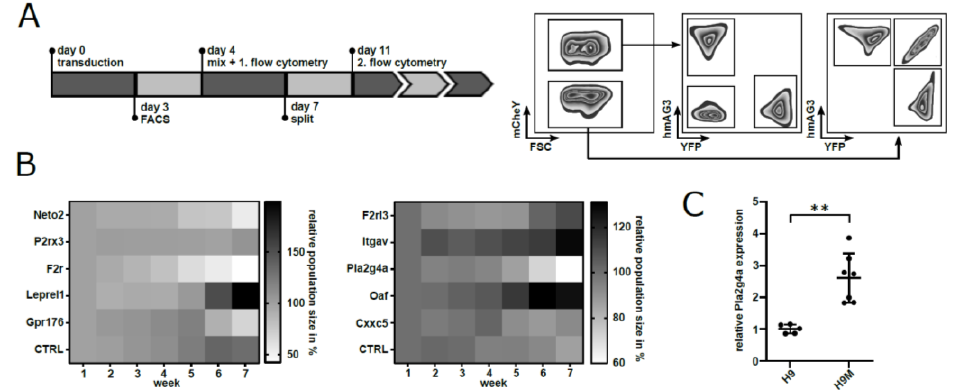
Figure 3. sgRNA screen in H9M cells reveals a growth requirement for PLA2G4A. ( A ) Experimental timeline. After purification of gene marked sgRNA-expressing cells, cell mixes of six different samples (5 sgRNAs + 1 control) were created and subsequently analyzed by flow cytometry for population sizes. A representative gating strategy for the assessment of population sizes is shown on the right. ( B ) Heatmap representing relative population sizes of sgRNA-transduced H9M cells in 6xFGB mixes over time ( n = 3). After 7 weeks, the Pla2g4a knockout population showed a decreased median population size of 63.68% compared to the initial measurement, while the control remained stable at 91.23%. ( C ) RT-qPCR analysis of Pla2g4a expression of independently transduced Hoxa9 (H9) and Hoxa9/Meis1 (H9M) cell lines (scatter dot plot, mean ± SD). Pla2g4a was significantly upregulated in H9M cells (Student’s t -test, p = 0.0011, mean = 2.61; ** = p < 0.005).